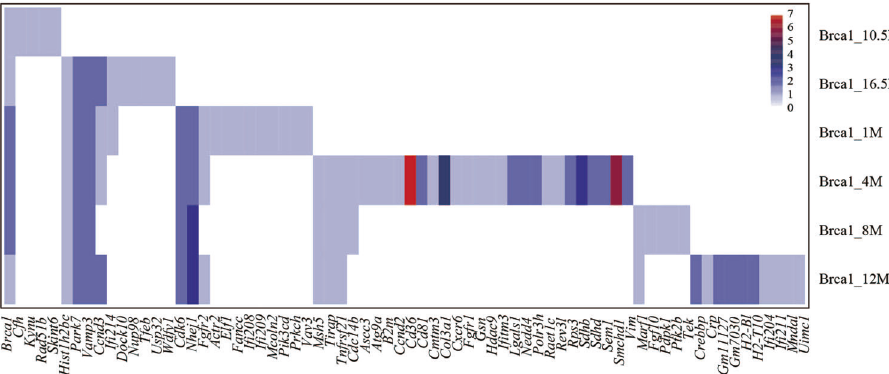
Fig. 2 Dynamic changes of functionally important genes disrupted by SVs from embryonic towards adulthood stages. Heatmap showed the functionally important genes affected by SVs in Brca1 + / − mice. Mutation frequency in the genes at each time point was represented in color gradient ranging from blue to red. It shows that certain disruptions generated at early developmental stage were constantly present across the entire developmental stage, whereas others were only present at given time point(s). Brca1 mutation (at the left) was present at each time